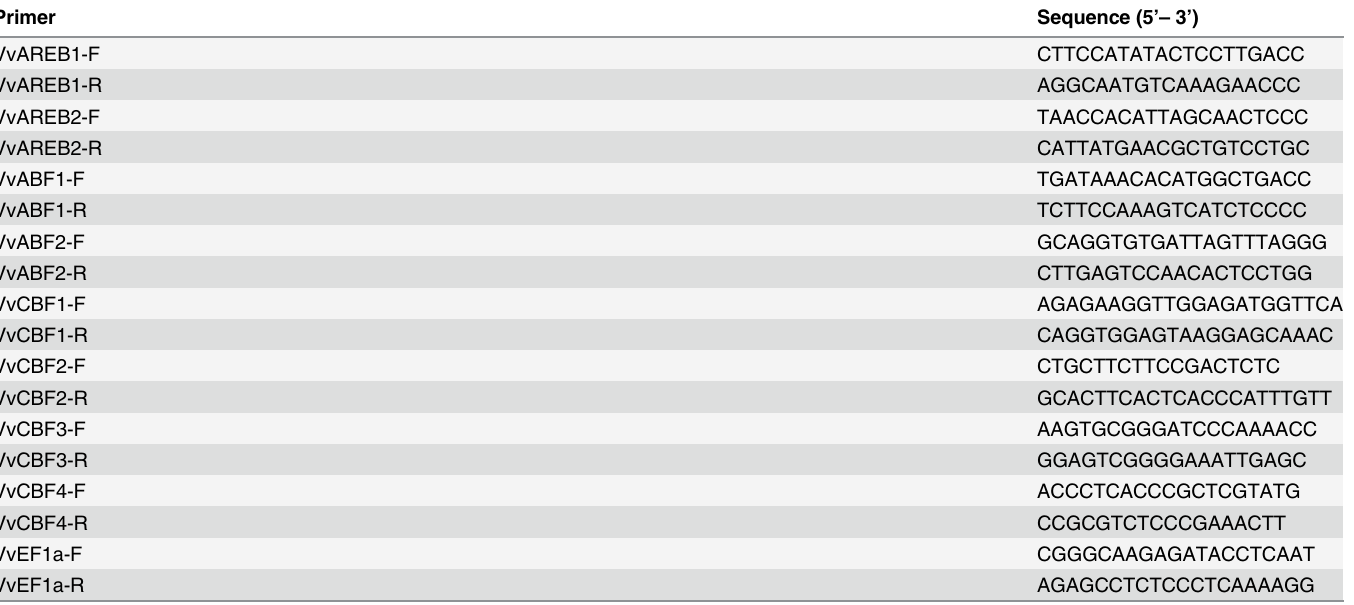
Table 1. Primer sequences of the genes used for expression analysis in